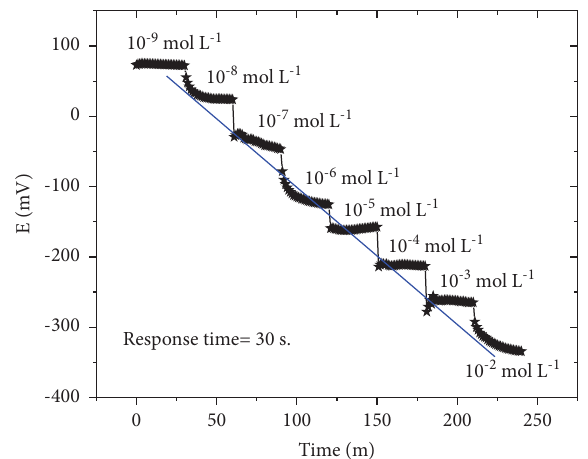
Figure 5: Dynamic response of the terbinafne screen-printed microchip.